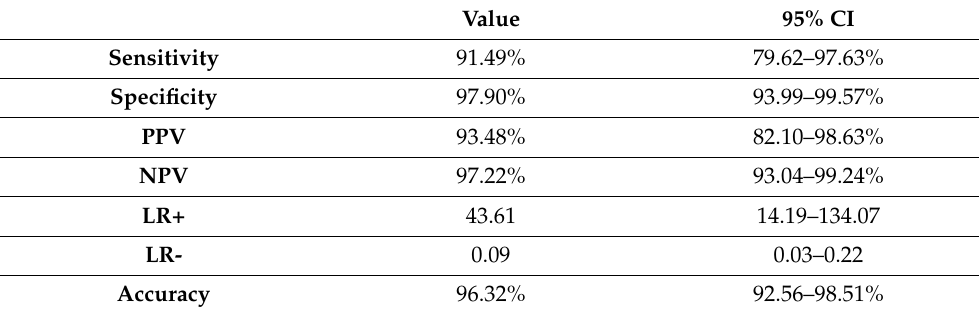
Table 3. Diagnostic values of the Humasis COVID-19 Ag